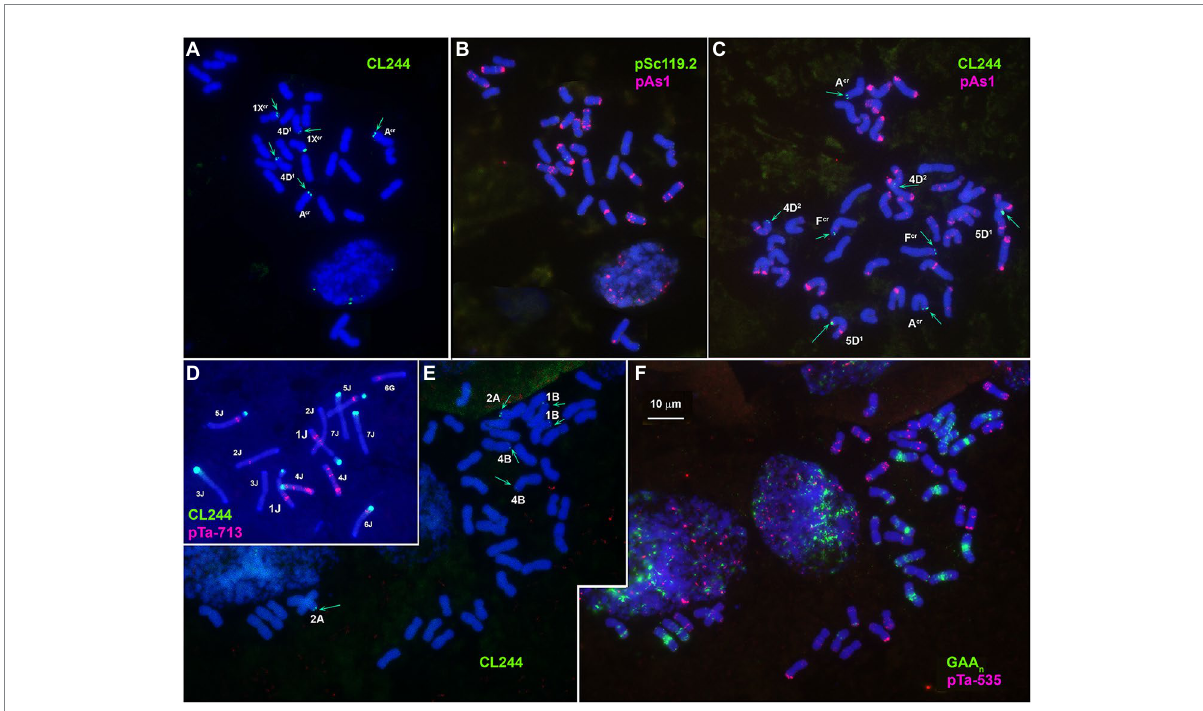
FIGURE 3 Localization of CL244 (green) repeat on Ae . crassa , 4x (A,B) , Ae . crassa , 6x (C) , Th . bessarabicum (D) , and common wheat (E,F) chromosomes. Chromosomes are identified using pAs1 ( B,C , red), pTa-713 ( D , red) or GAA n ( F , green) and pTa-535 ( F , red). Chromosomes carrying CL244 signals are indicated. Scale bar, 10